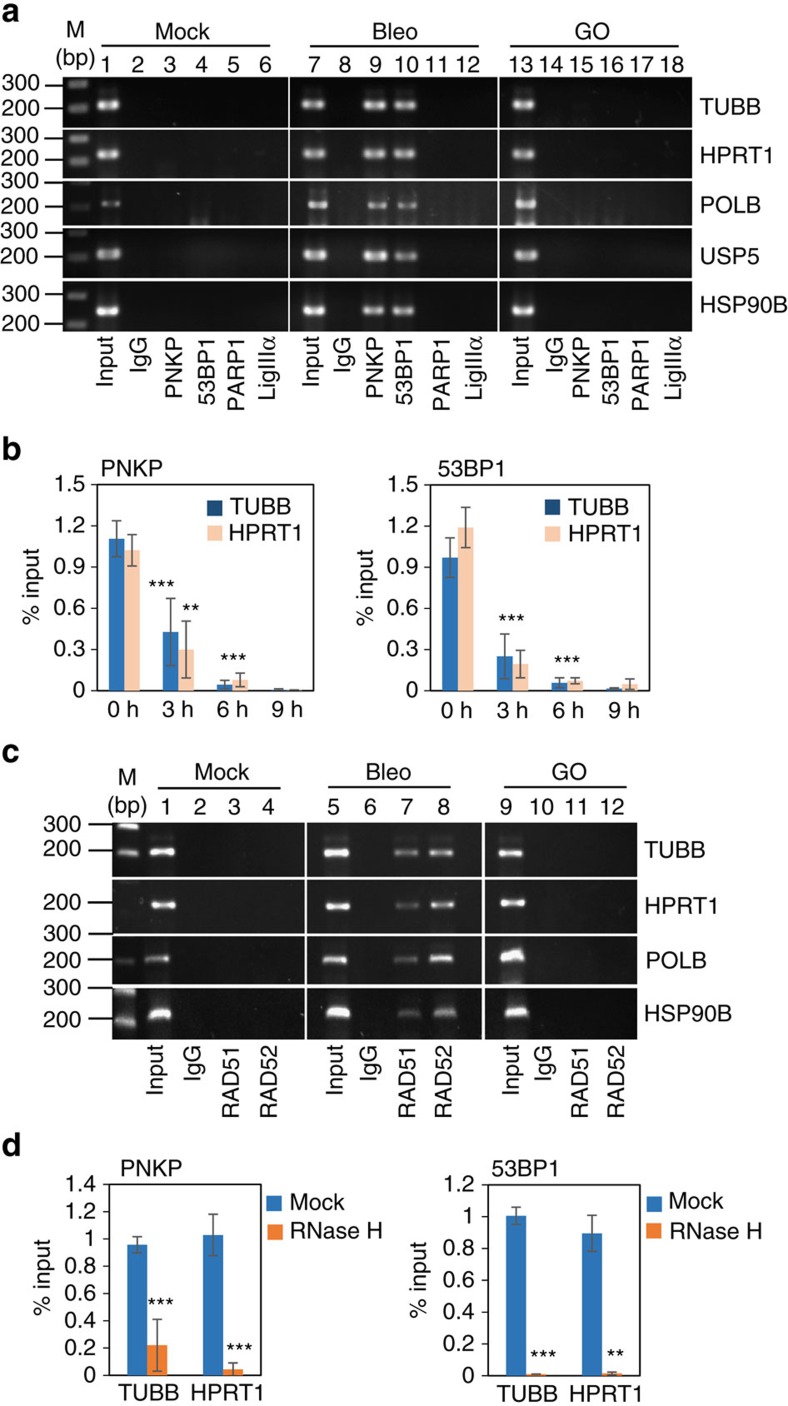
C-NHEJ pathway utilizes RNA as a template for error-free repair.(a) HEK293 cells were mock-treated or treated with Bleo or GO and their NEs subjected to RNA-ChIP analysis using the indicated Abs. RT-PCR was carried out for TUBB, HPRT1, POLB, USP5 and HSP90B genes using intron-specific primers. Lanes: 1, 7 and 13 represent 1% inputs, collected before IPs, and M shows a 1 kb DNA ladder. The image shown here is representative of plus reverse transcriptase (+RT) reactions in three independent experiments. (b) Time-course analysis, where 1 h Bleo-treated HEK293 cells were washed with PBS before they were allowed to recover for the indicated times, and NEs were subjected to RNA-ChIP using anti-PNKP or -53BP1 Abs. Real-time assays were done using intron-specific primers for TUBB and HPRT1, and per cent inputs were calculated using Ct values; error bars represent ±s.d. of the mean (n≥3). The dissociation of pre-mRNA from the complex at 3 and 6 h is significant (**P<0.01; ***P<0.005) compared with 0 h. (c) RNA-ChIP analysis was done with NE from mock-, Bleo- or GO-treated HEK293 cells using anti-RAD51 and -RAD52 Abs, then RT-PCRs were performed with intron-specific primers for the indicated genes. Lanes 1, 5 and 9 shows 1% input collected before IPs. Representative images for +RT reactions in three independent experiments are shown here. (d) Bleo-treated cells were incubated with RNase H, before RNA-ChIP assays using Abs against PNKP and 53BP1, to detect RNA–DNA hybrids and real-time qPCRs were done using intron-specific primers for TUBB or HPRT1. Data are presented as per cent input where error bars show ±s.d. of the mean (n=3, **P<0.01, ***P<0.005).